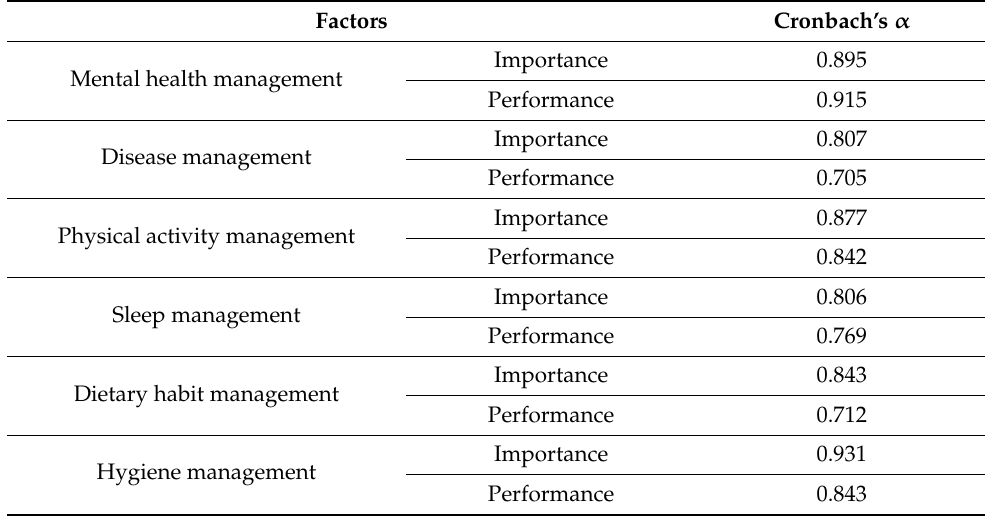
Table 2. Results of the reliability